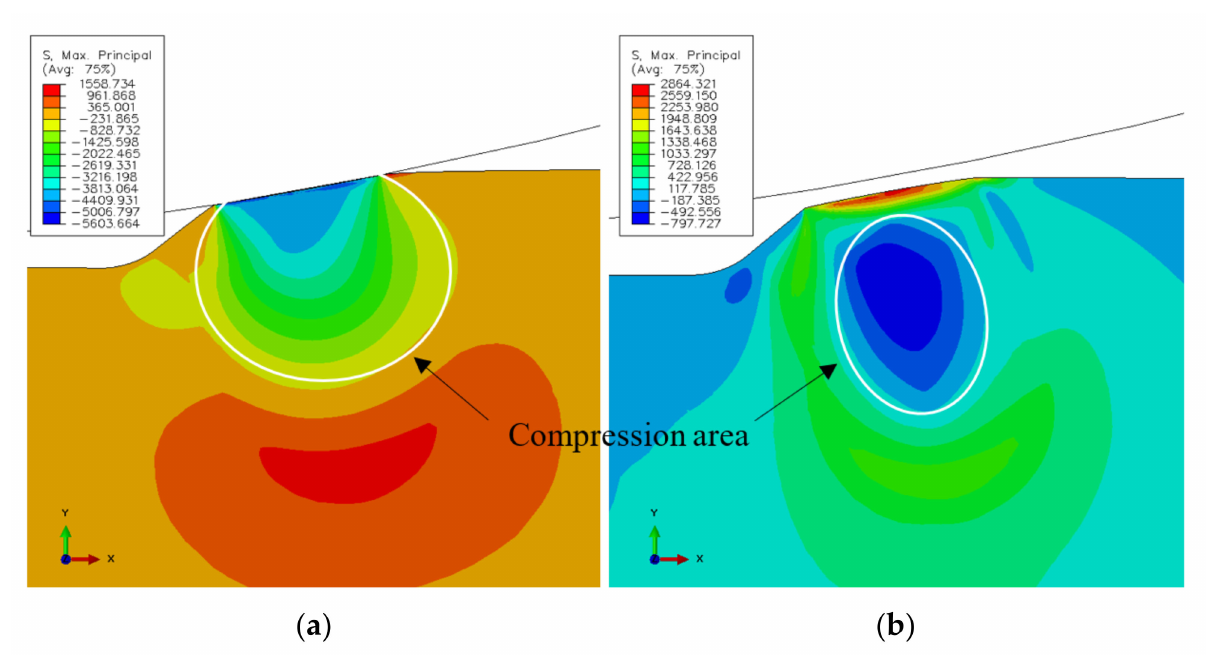
Figure 4. Maximum principal stress at the spall edge at the ( a ) loading and ( b ) unloading of the RE-spall interaction.